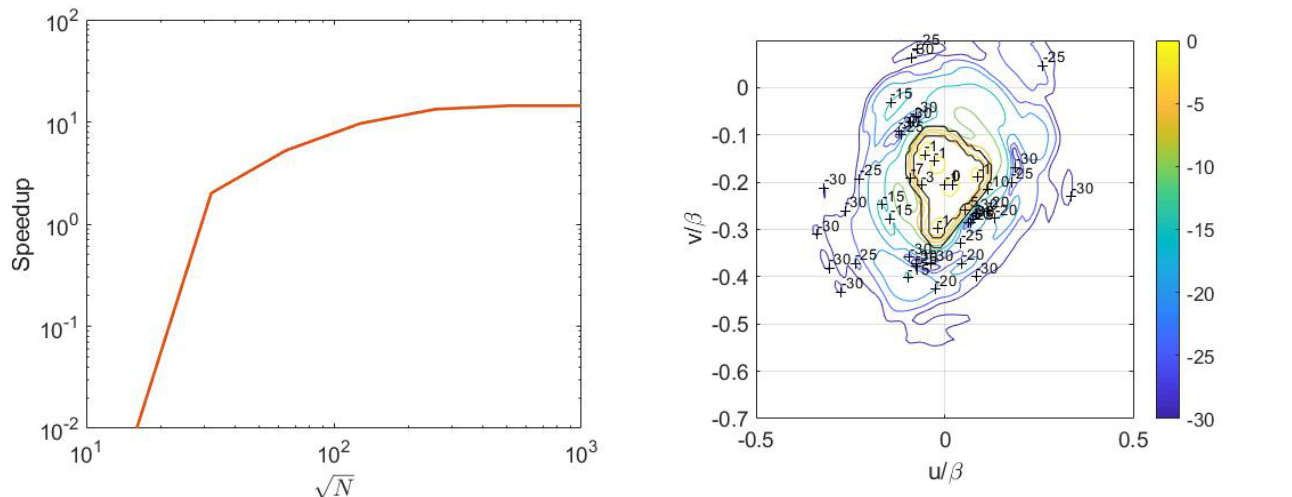
FIGURE 5. Directivity pattern synthesized after stage 3).